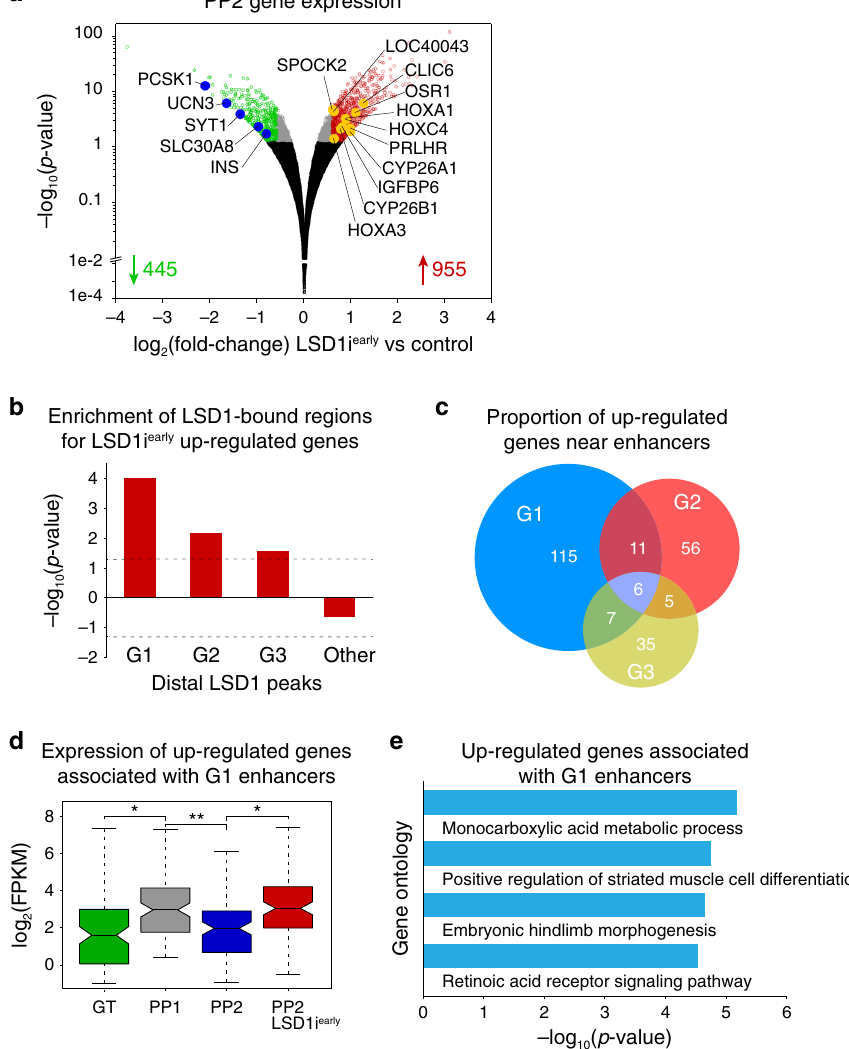
Fig. 3 LSD1 activity is necessary for repressing transiently expressed retinoic acid-dependent genes. a Volcano plot of differentially expressed genes at PP2 after LSD1 inhibition from PP1 to PP2 (TCP, LSD1i early ). Differential expression calculated with DESeq2 and genes with ≥ 1.5-fold change up or down. Adjusted p -values of <0.05 were considered differentially expressed. 445 genes were downregulated and 955 were upregulated in LSD1i early PP2 cells. Black dots indicate genes not signi fi cantly changed ( p -value > 0.05), grey dots genes signi fi cantly changed ( p -value < 0.05) but less than 1.5-fold compared to control, red and green dots genes signi fi cantly up- and downregulated ( p -value < 0.05 and ≥ 1.5-fold change), respectively ( n = 2 replicates from independent differentiations). b Enrichment analysis of genes upregulated by LSD1i early within 100 kb of G1, G2 and G3 or other distal LSD1 peaks. Dashed lines indicate p -value = 0.05 for enrichment (positive value) or depletion (negative value), permutation test. c Percentage of LSD1i early upregulated genes near G1 ( n = 139), G2 ( n = 78) and G3 ( n = 53) enhancers (within 100 kb). d Box plot of mRNA levels for 139 LSD1i early upregulated genes near G1 enhancers. Plots are centred on median, with box encompassing 25th – 75th percentile and whiskers extending up to 1.5 interquartile range (Tukey style). P = 2.30 e − 3, 4.38 e − 6, and 2.25 e − 7, respectively, Wilcoxon rank-sum test, 2 sided. e Gene ontology analysis for 139 LSD1i early upregulated genes near G1 enhancers. GT, primitive gut tube; PP1, early pancreatic progenitors; PP2, late pancreatic